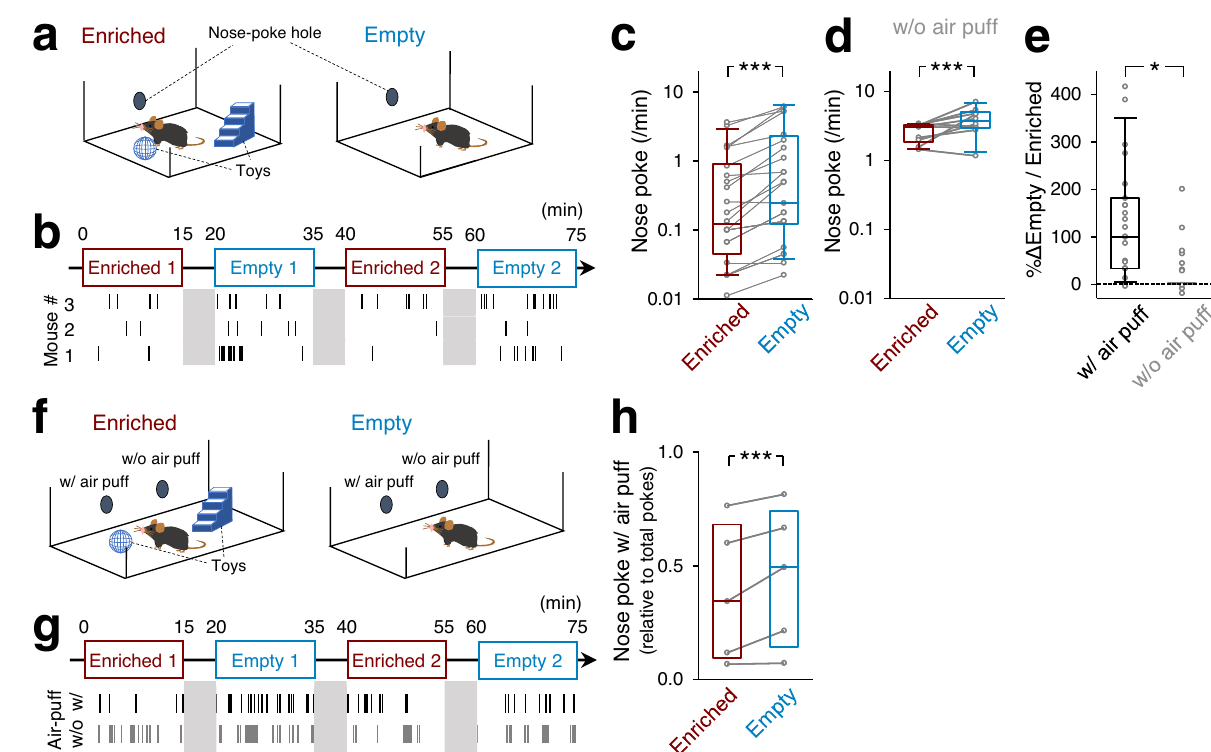
Fig. 1 | Mice received air-puff stimuli more frequently in an empty chamber. a The experimental design for our behavioral test. When mice poked their noses intoahole on achamber wall,theyreceived abrief air-puffstimulus. Thechamber was equipped with (enriched) or without (empty) toys. b Time schedules of the behavioral test. Each mouse was alternately placed in an enriched or empty chamberfor15mineachwithanintervalof5min.Thebottomrasterplotindicates the timings of nose pokes of three representative mice. c Frequencies of nose pokes in enriched and empty rooms. The box plots indicate the median, inter- quartile range, and extreme values. Each line indicates a single mouse, and the values at both ends represent the averages of two sessions. *** P <0.0001, n =23 mice,two-sidedpairedbootstraptest. d Thesameas(c)butforthewithout-airpuff conditions. *** P <0.0001, n =10 mice, two-sided paired bootstrap test. e Percent